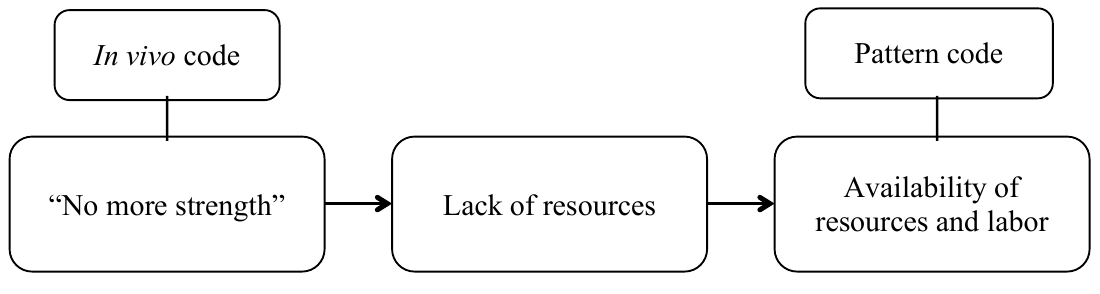
Fig. A2.1. Flow diagram illustrating an example of the process of first- and second-round coding to derive factors that influence the